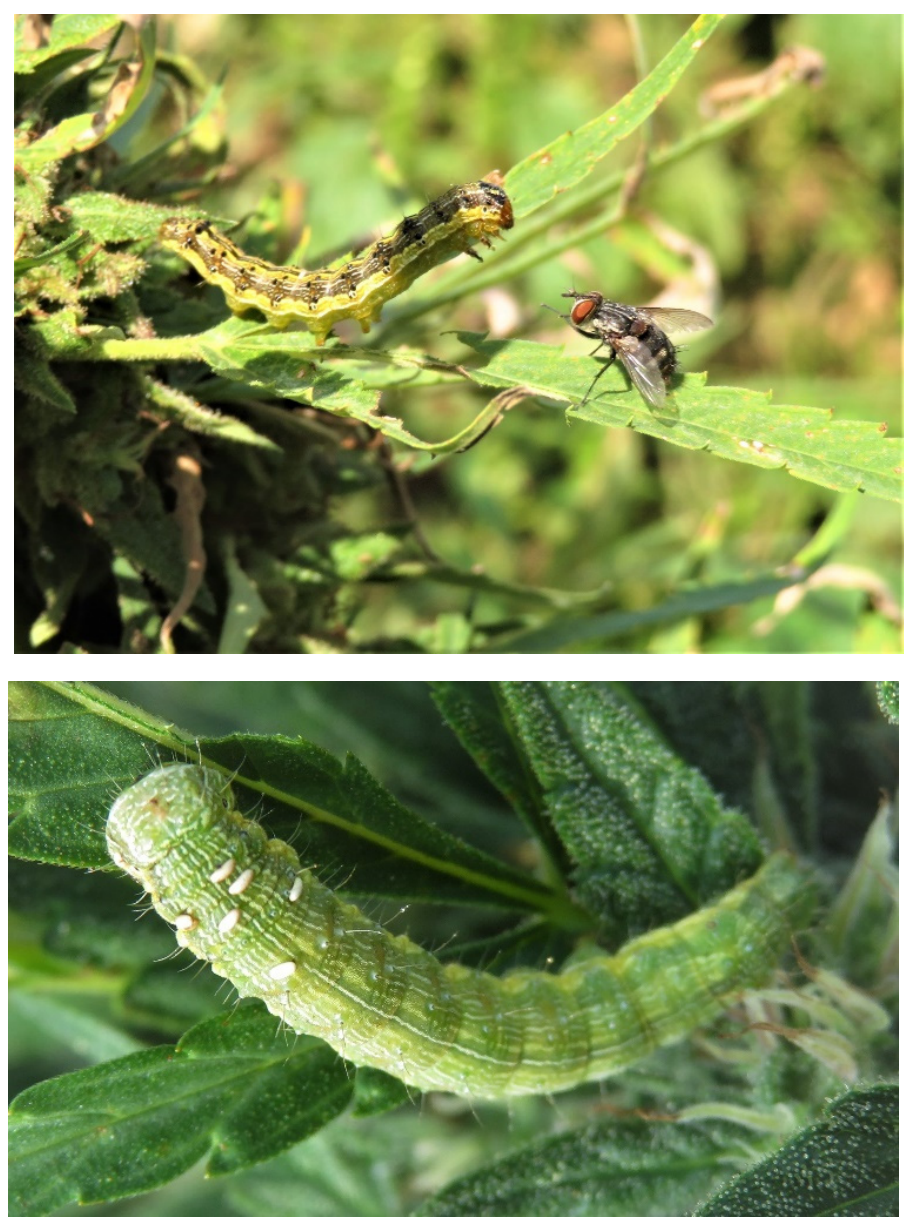
Figure 1. Winthemia rufopicta preparing to lay eggs on a CEW larva ( top ). Caterpillar of H. zea with attached eggs of W. rufopicta on the thorax ( bottom ).